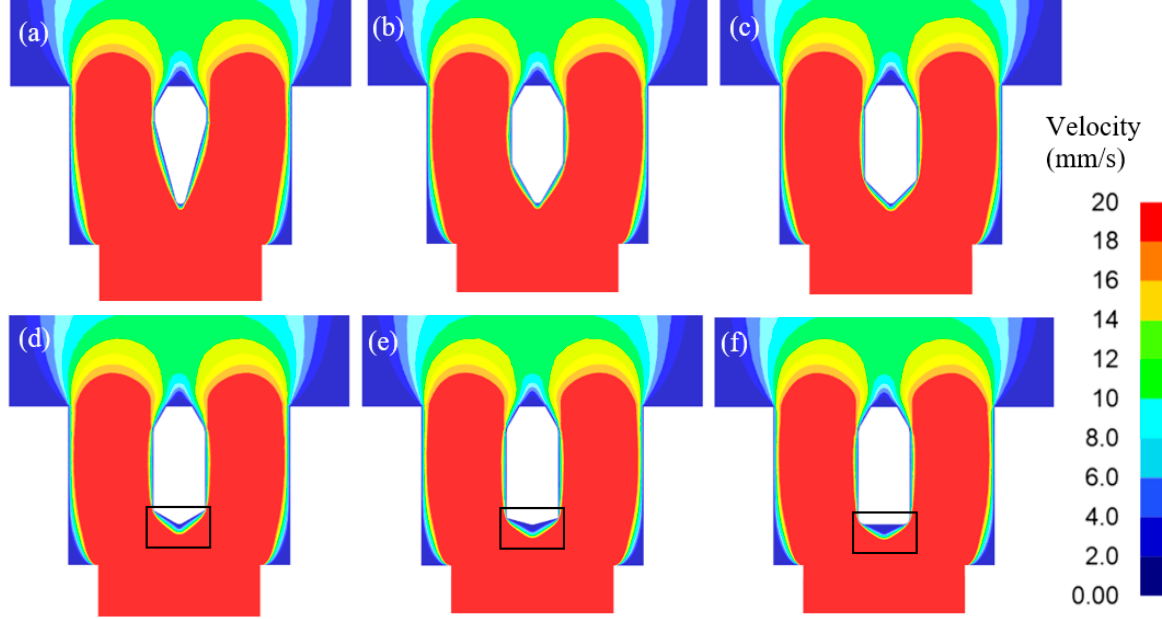
Figure 7. Cross-sectional view of the model-predicted velocity distribution in the welding chamber for different lower bridge angles: ( a ) 15°, ( b ) 30°, ( c ) 45°, (d) 60°, ( e ) 75° and ( f ) 90°. Table 2. The time needed for the seam material to pass through the porthole and welding stage.